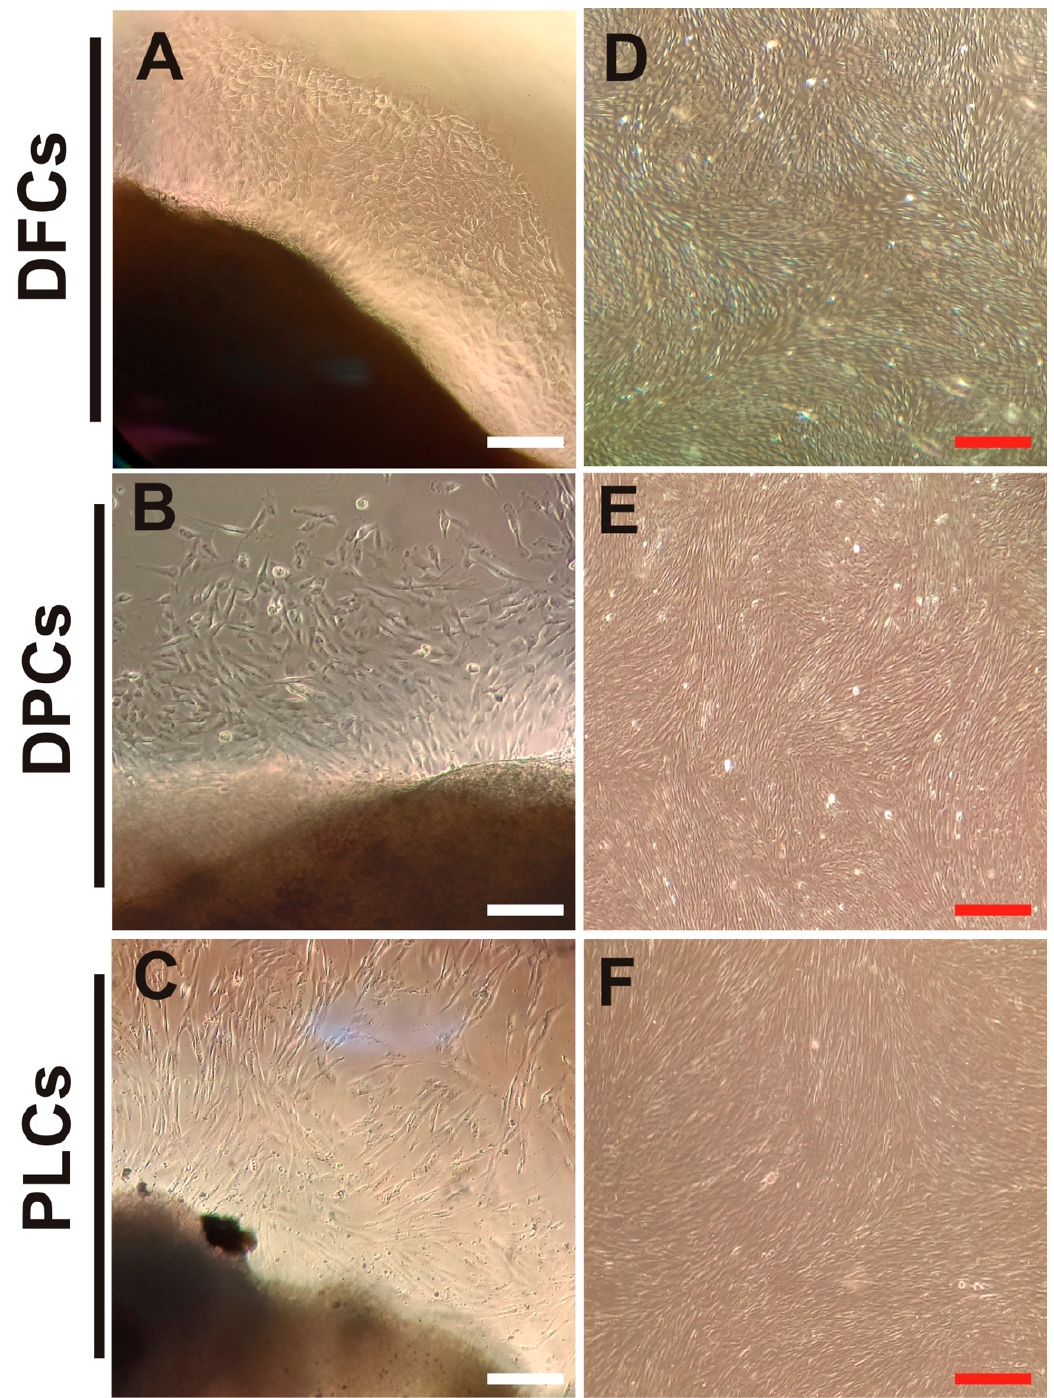
Figure 1. Morphology of primary cultures of human dental follicle cells (DFCs), dental pulp cells (DPCs), and periodontal ligament cells (PLCs). ( A – C ) Typical outgrowing fibroblast-like cells from DFCs, DPCs, and PLCs after 10 days of culture. ( D – F ) Representative isolated cells at the second passage (P2) of DFCs, DPCs, and PLCs, respectively, showing uniform morphology. The white and red scale bar indicates 150 and 200 μ m, respectively.